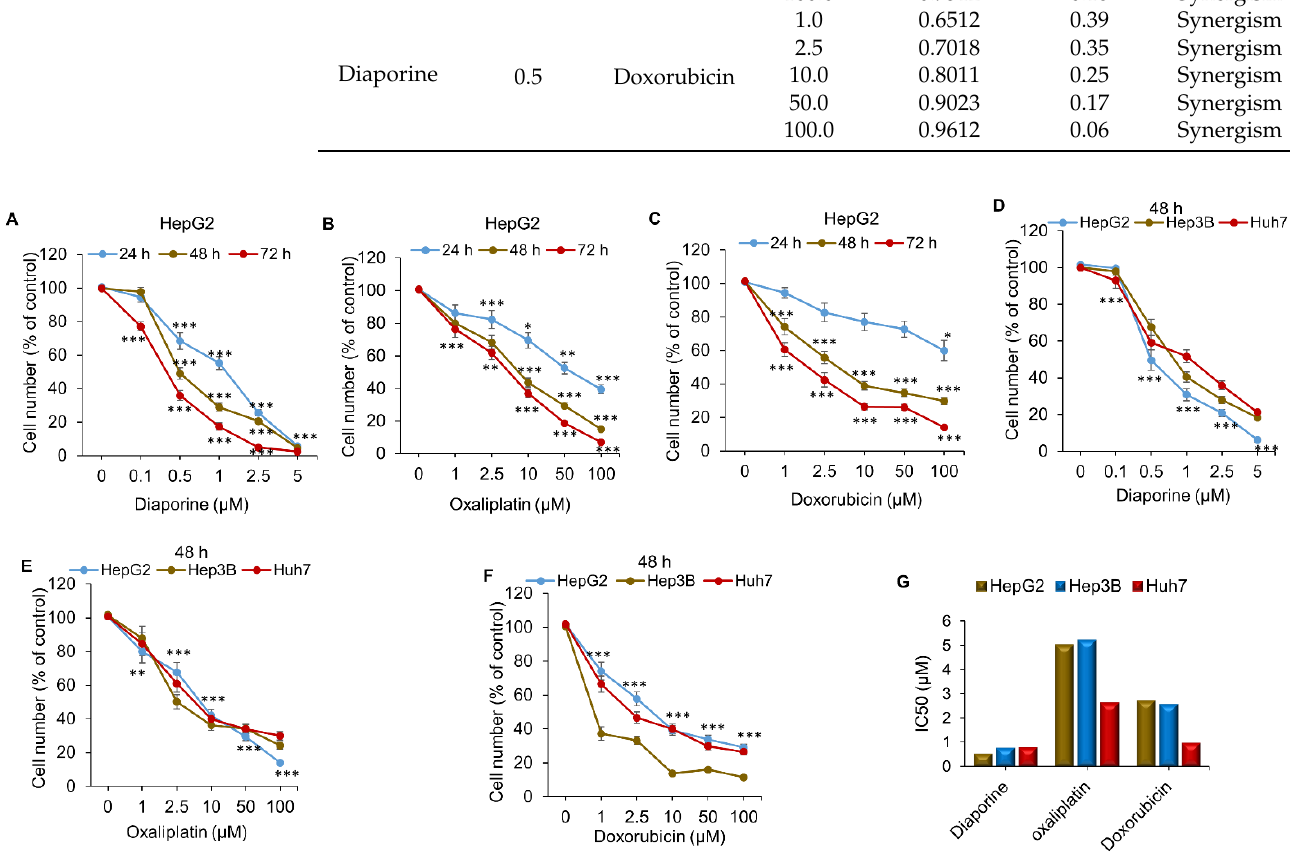
Figure 1. Comparison of the inhibitory effect of diaporine on the number of hepatocellular carcinoma cells with oxaliplatin and doxorubicin. Exponentially growing HepG2 cells were incubated with vehicle (0.1%DMSO), diaporine ( A ), oxaliplatin ( B ), and doxorubicin ( C ) at the indicated concentration for 24–72 h. The effects of these three drugs on the other two hepatoma cell lines, Hep3B and HuH7, were confirmed at 48 h ( D – F ). Cell counts were performed as described in the Materials and Methods. ( G ). IC50 ( µ M) of diaporine compared with those of oxaliplatin and doxorubicin at 48 h of treatment. All the experiments were independently repeated 3 times. The data are presented as SEM. * p < 0.05; ** p < 0.01; *** p <